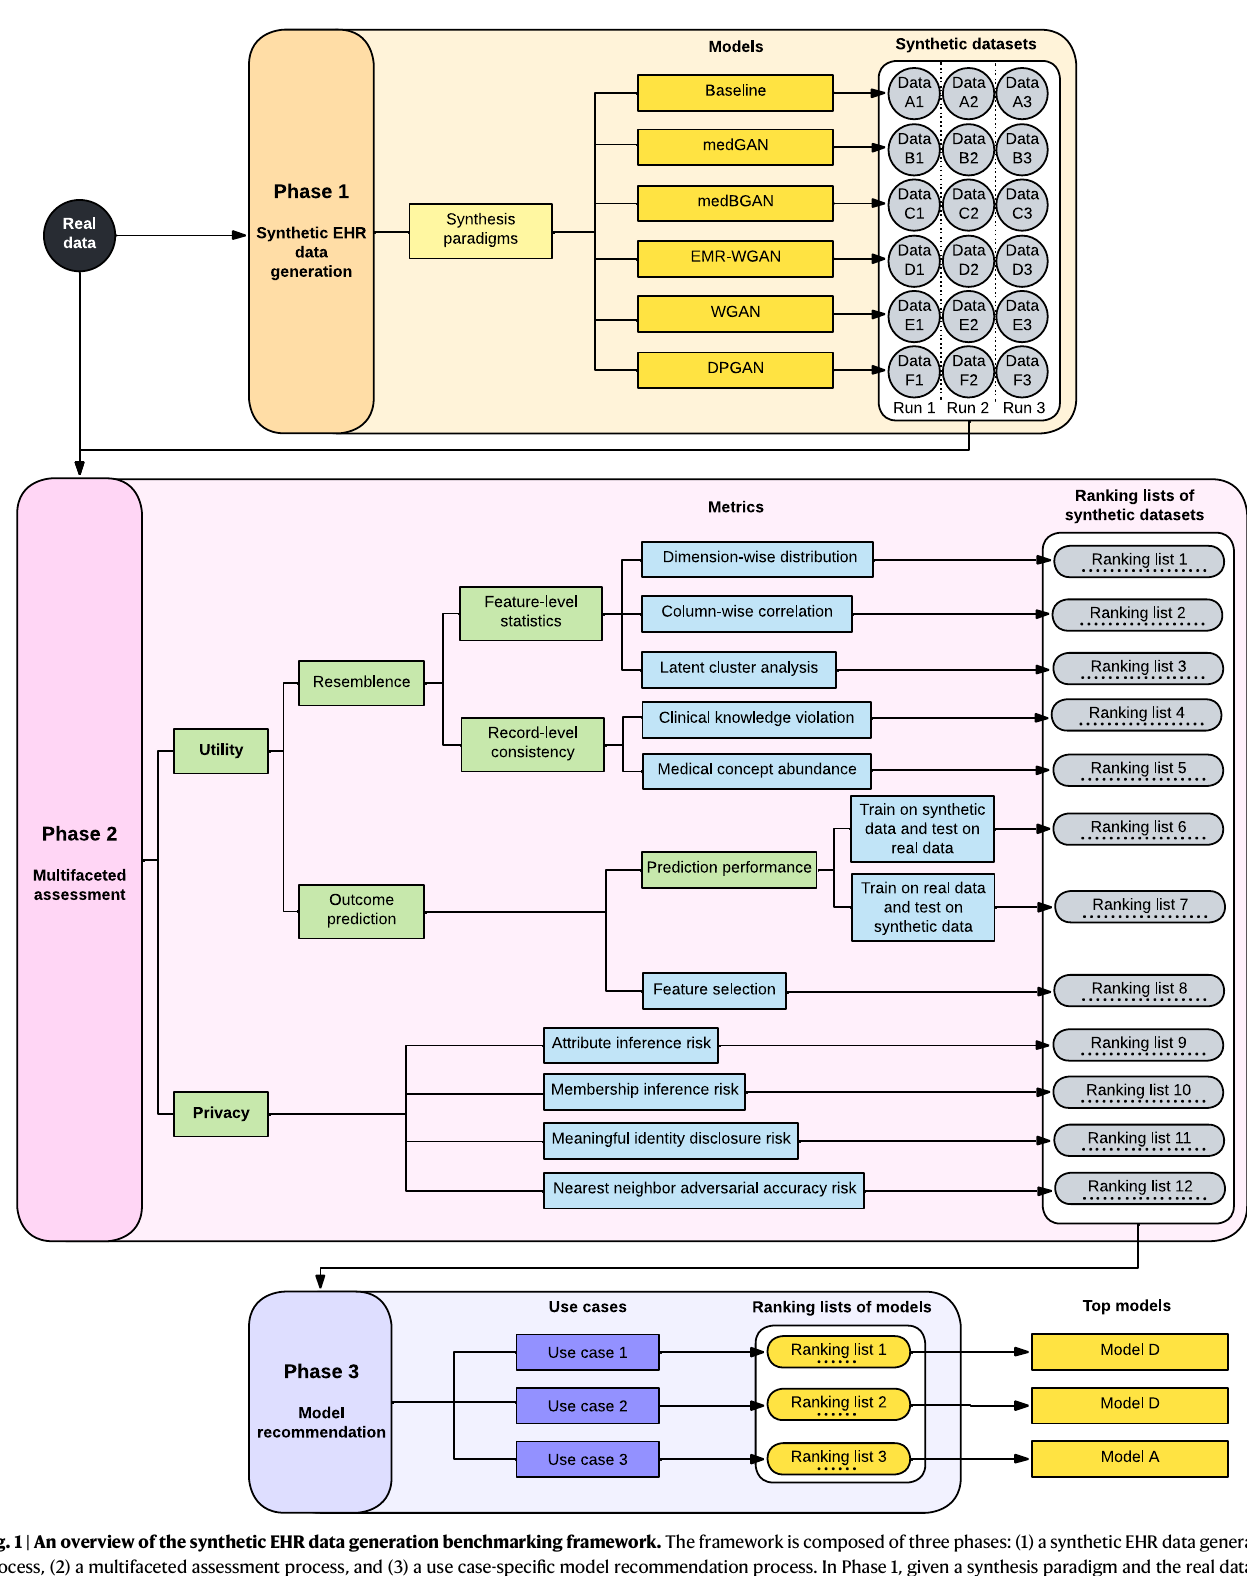
Fig.1|AnoverviewofthesyntheticEHRdatagenerationbenchmarkingframework. Theframeworkiscomposedofthreephases:(1)asyntheticEHRdatageneration process, (2) a multifaceted assessment process, and (3) a use case-speci fi c model recommendation process. In Phase 1, given a synthesis paradigm and the real data, we generatemultiple(speci fi cally,threeinourexperiments)syntheticdatasetsusingeachdatagenerationmodel.InPhase2,eachgeneratedsyntheticdatasetisassessedand assigned a value in termsof each assessment metric.Afterward, allsyntheticdatasetswillbe rankedaccording totheirvaluesintermsofeachmetric.InPhase3,foreach usecase,weassignaweighttoeachmetricandconvertmultiple(speci fi cally,twelveinourexperiments)rankinglistsofsyntheticdatasetsintoonerankinglistofmodels. Finally, the top ranked model for each use case is recommended. EHR: electronic health